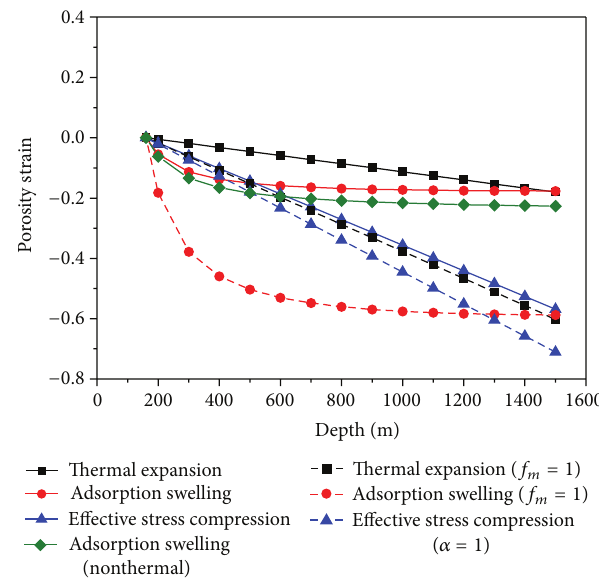
Figure 9: Contributions to the porosity deformation.